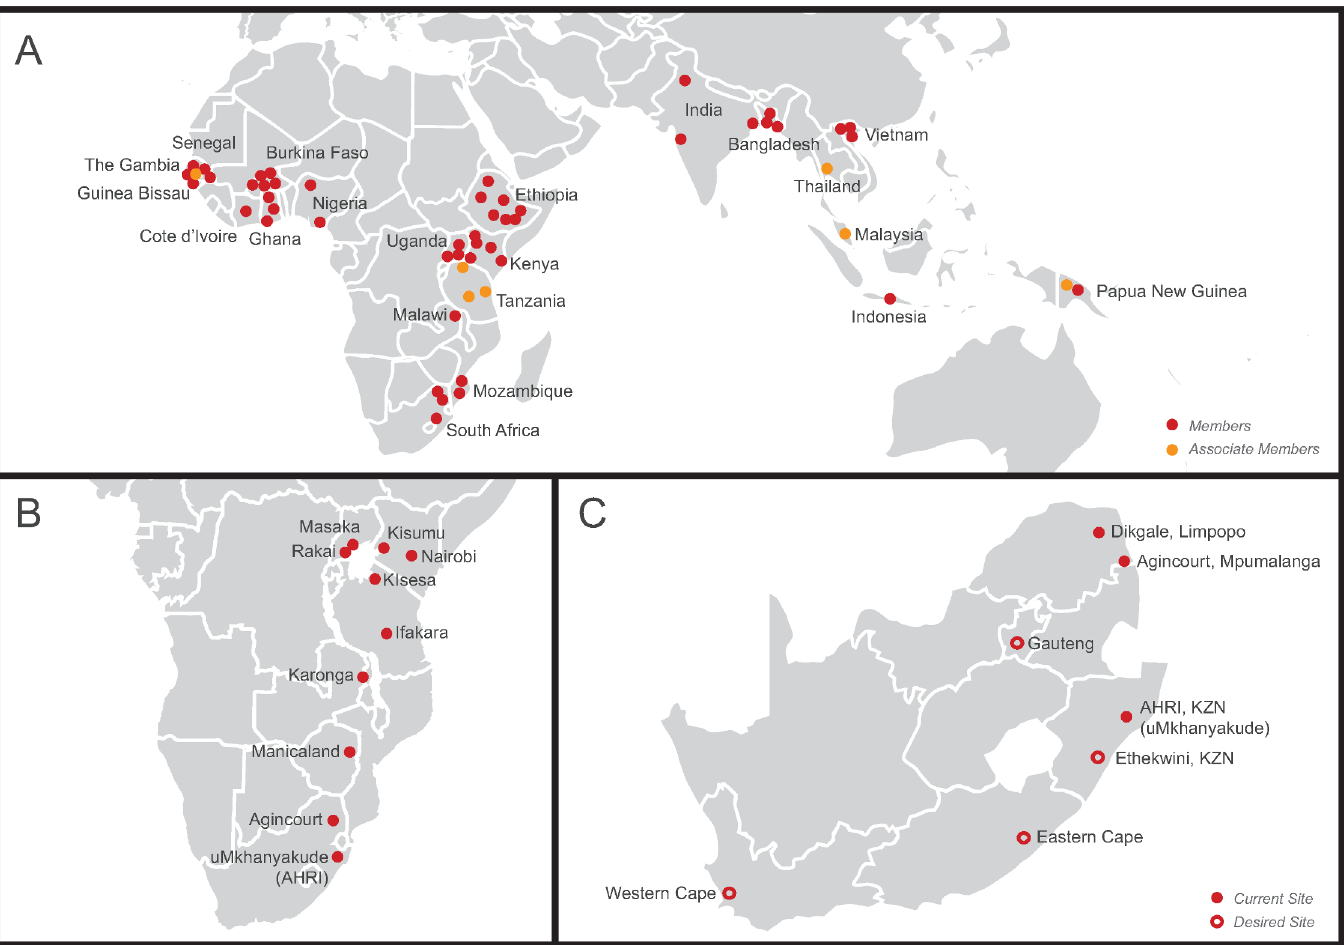
Fig 3. Maps illustrating networks of health and demographic surveillance sites (HDSSs) at the global, regional, and national level. (A) International Network for the Demographic Evaluation of Populations and their Health (INDEPTH Network), a network of 48 members and 7 associate members in 21 low- and middle-income countries in Africa, Asia, and Oceania conducting population-based surveillance of the health status of communities (modified from http://www.indepth-network.org/ member-centres). (B) Network for Analysing Longitudinal Population-based HIV/AIDS data on Africa (ALPHA Network), a network of 10 centres in sub-Saharan Africa conducting population-based HIV surveillance (modified from http://alpha.lshtm.ac.uk/partner-study-institutions/). (C) South African Population Research Infrastructure Network (SAPRIN), an expanding network of HDSSs in South Africa (modified from http://saprin.mrc.ac.za/nodes.html). AHRI, Africa Health Research Institute; KZN,